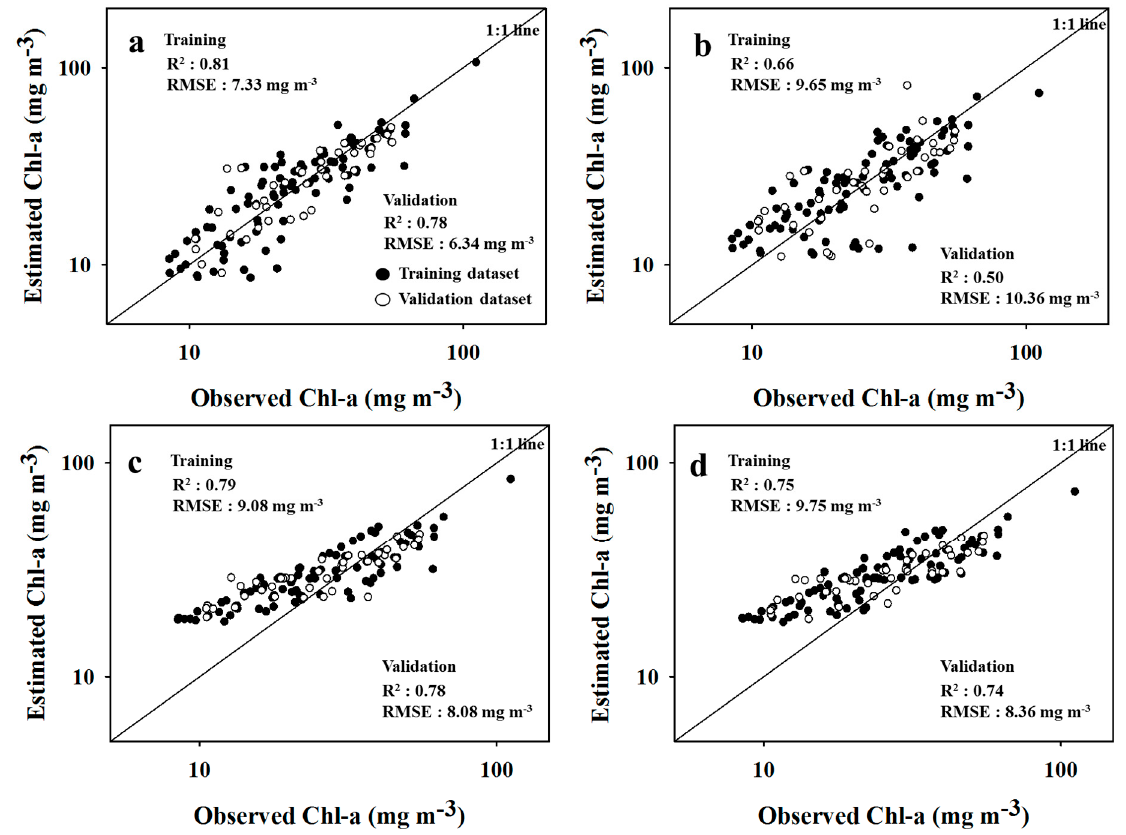
Figure 7. Training and validation results of Chl-a estimation, ( a ) SAE-ANN, ( b ) ANN, ( c ) SAE-SVR, and ( d ) SVR. Black and white dots represent training and validation results, respectively.